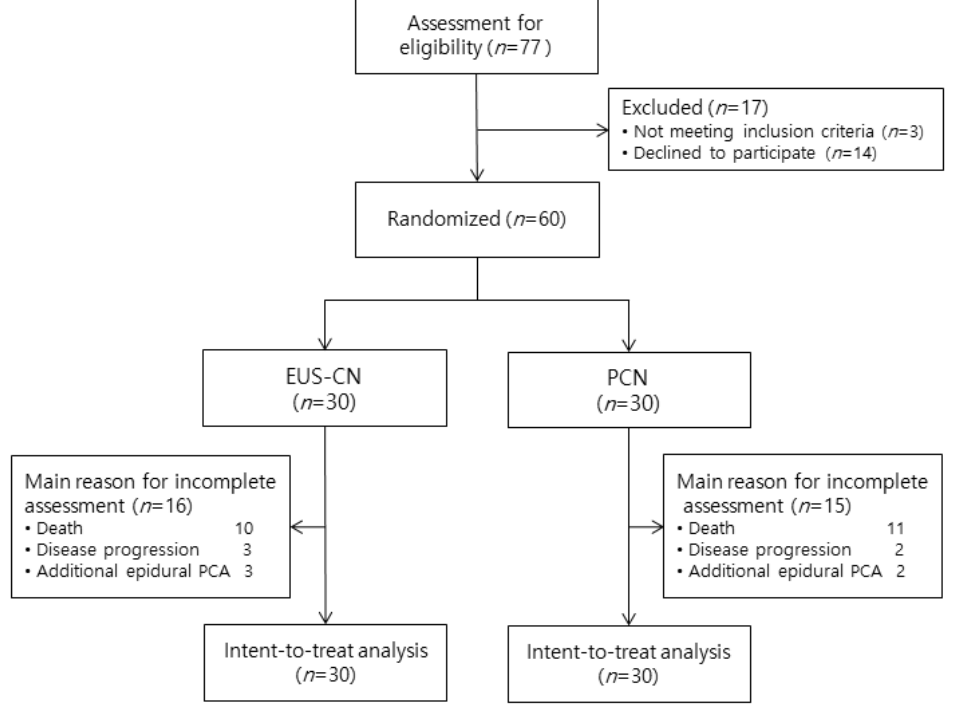
Figure 2. Patient flow diagram. EUS-CN, endoscopic ultrasound-guided celiac neurolysis; PCN, percutaneous celiac neurolysis; PCA, patient-controlled analgesia.